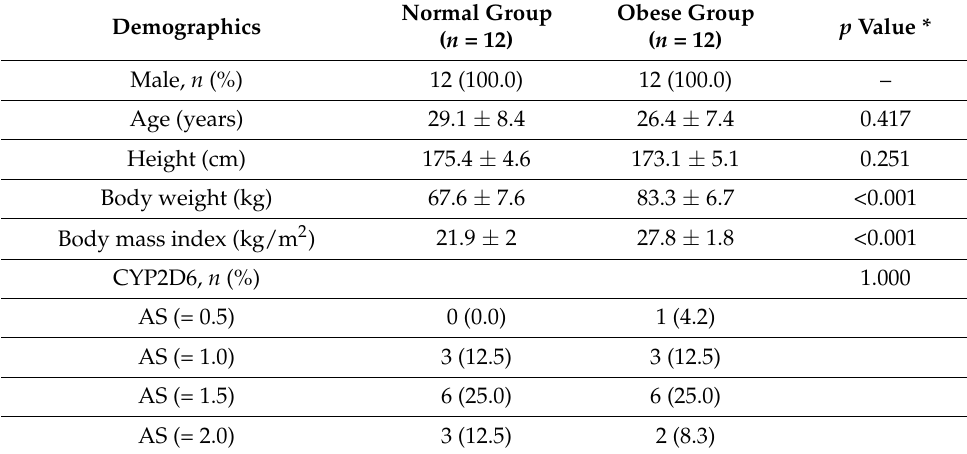
Table 1. Baseline characteristics of the study